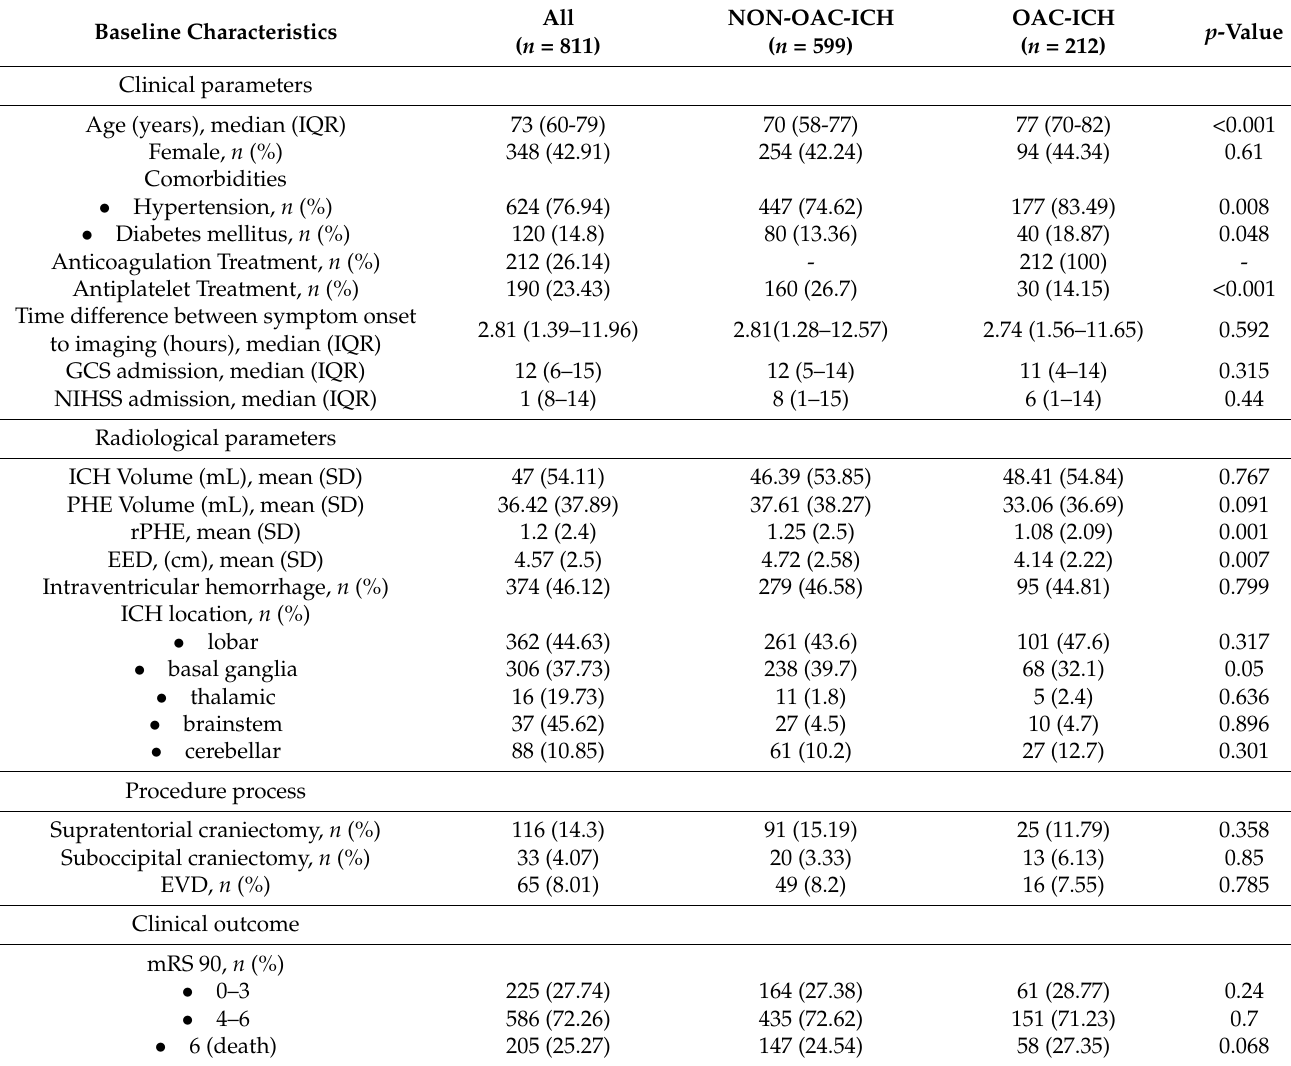
Table 1. Baseline demographic and clinical characteristics of patients with non-oral anticoagulation associated intracerebral hemorrhage (NON-OAC-ICH) and oral anticoagulation associated intracerebral hemorrhage (OAC-ICH). Baseline